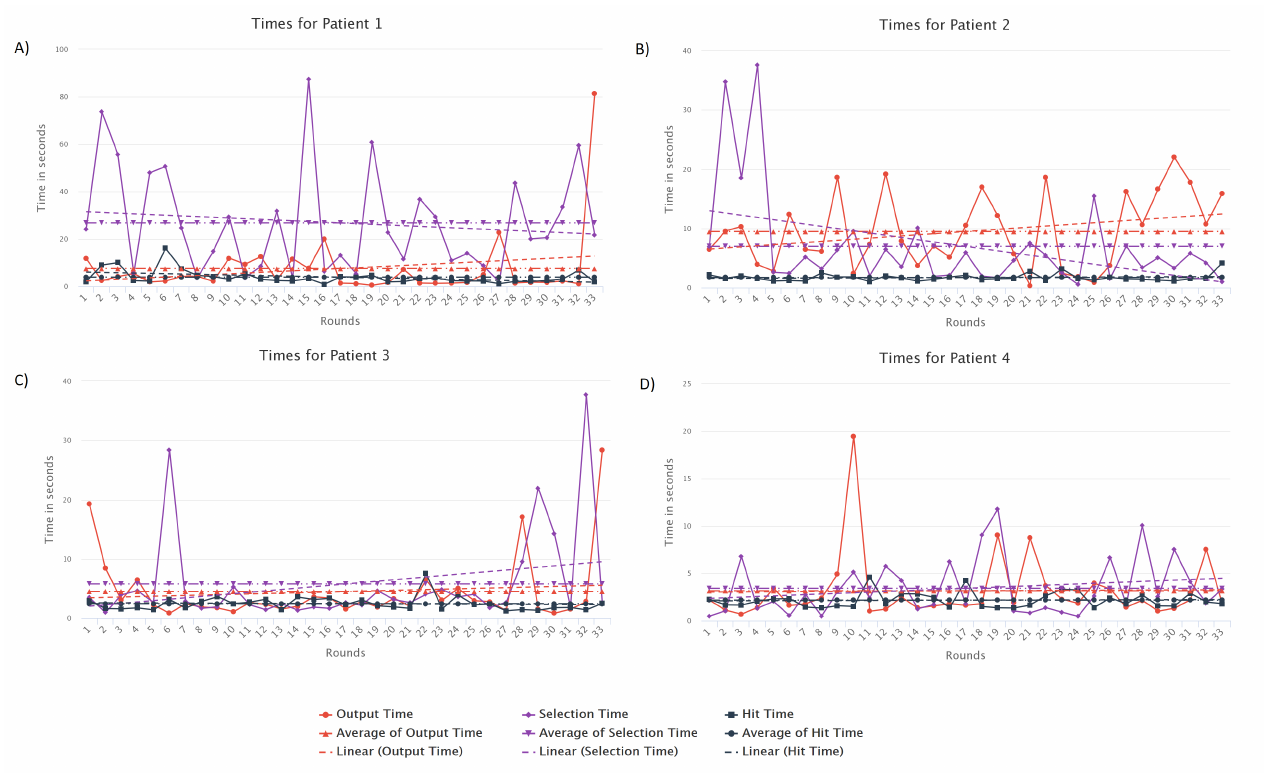
Figure 12: Game times for the four